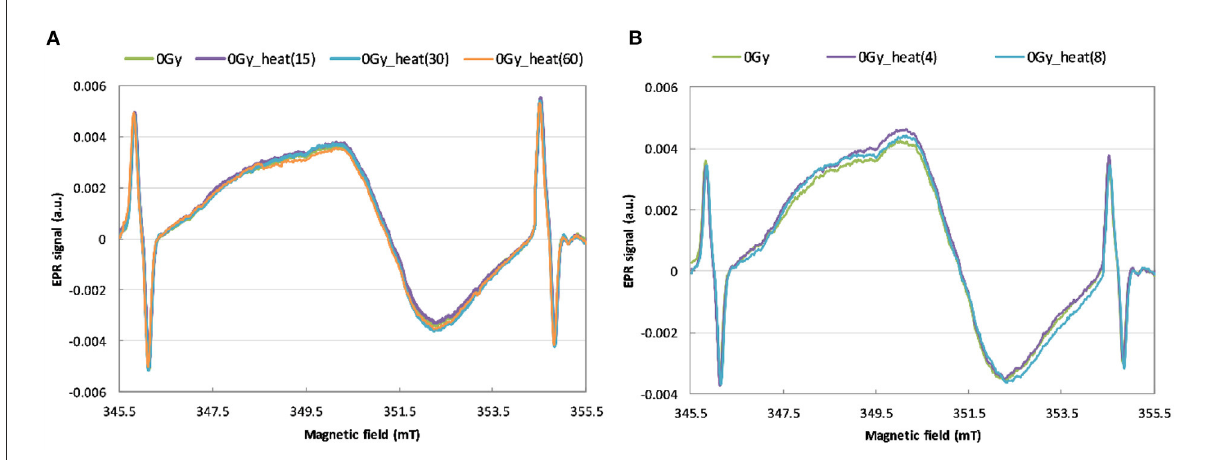
FIGURE5 EPR spectra of unirradiated WG samples before and after annealing for 15, 30 and 60min at 200 ◦ C (A) and for 4 and 8min at 250 ◦ C (B)